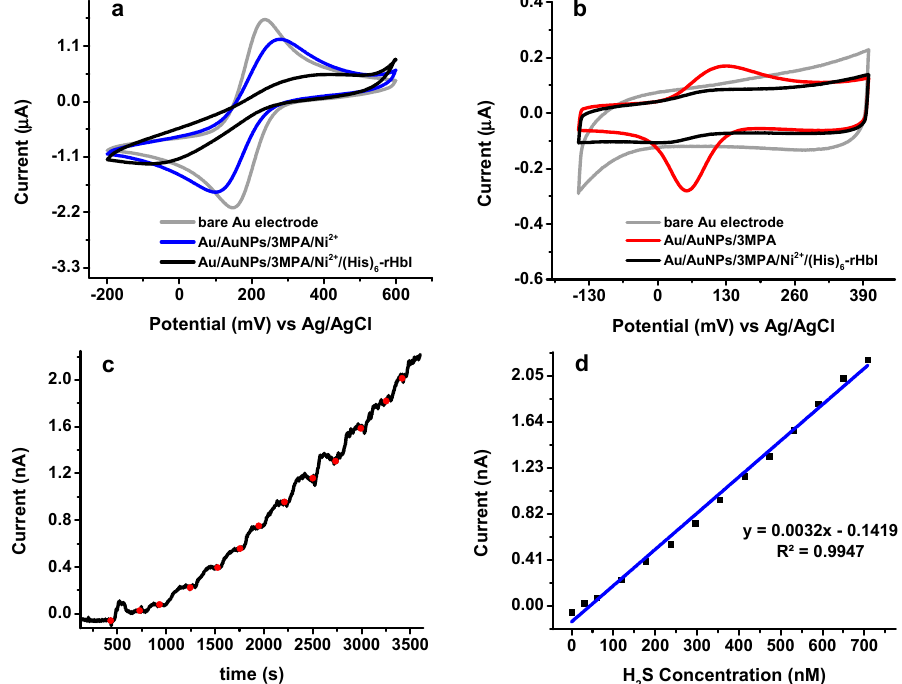
Figure 6. Electrochemical analysis: ( a ) CV in 1.0 mM K 3 Fe(CN)6/0.1 M KCl at 20 mV/s; ( b ) CV in phosphate buffer, pH = 7 at 20 mV/s; ( c ) direct current potential amperometry under an operating potential of 230 mV in phosphate buffer pH = 6.5 with Au/AuNPs/3MPA/Ni 2+ /rHbI electrode; ( d ) corresponding calibration curve of amperometric response toward H 2 S.